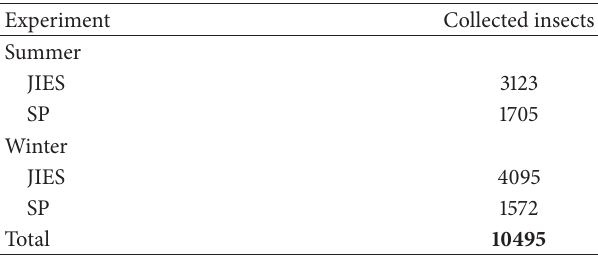
Table 1: Number of specimens